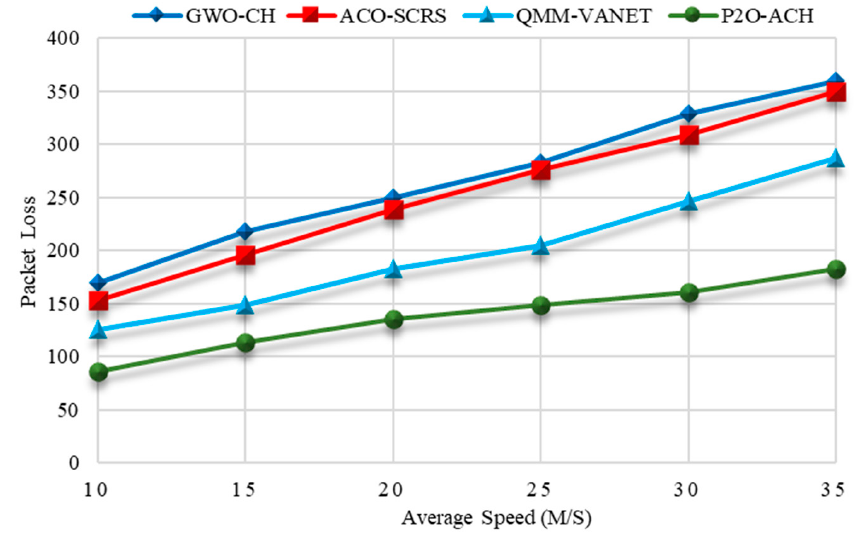
Figure 12. Packet Loss Calculation.